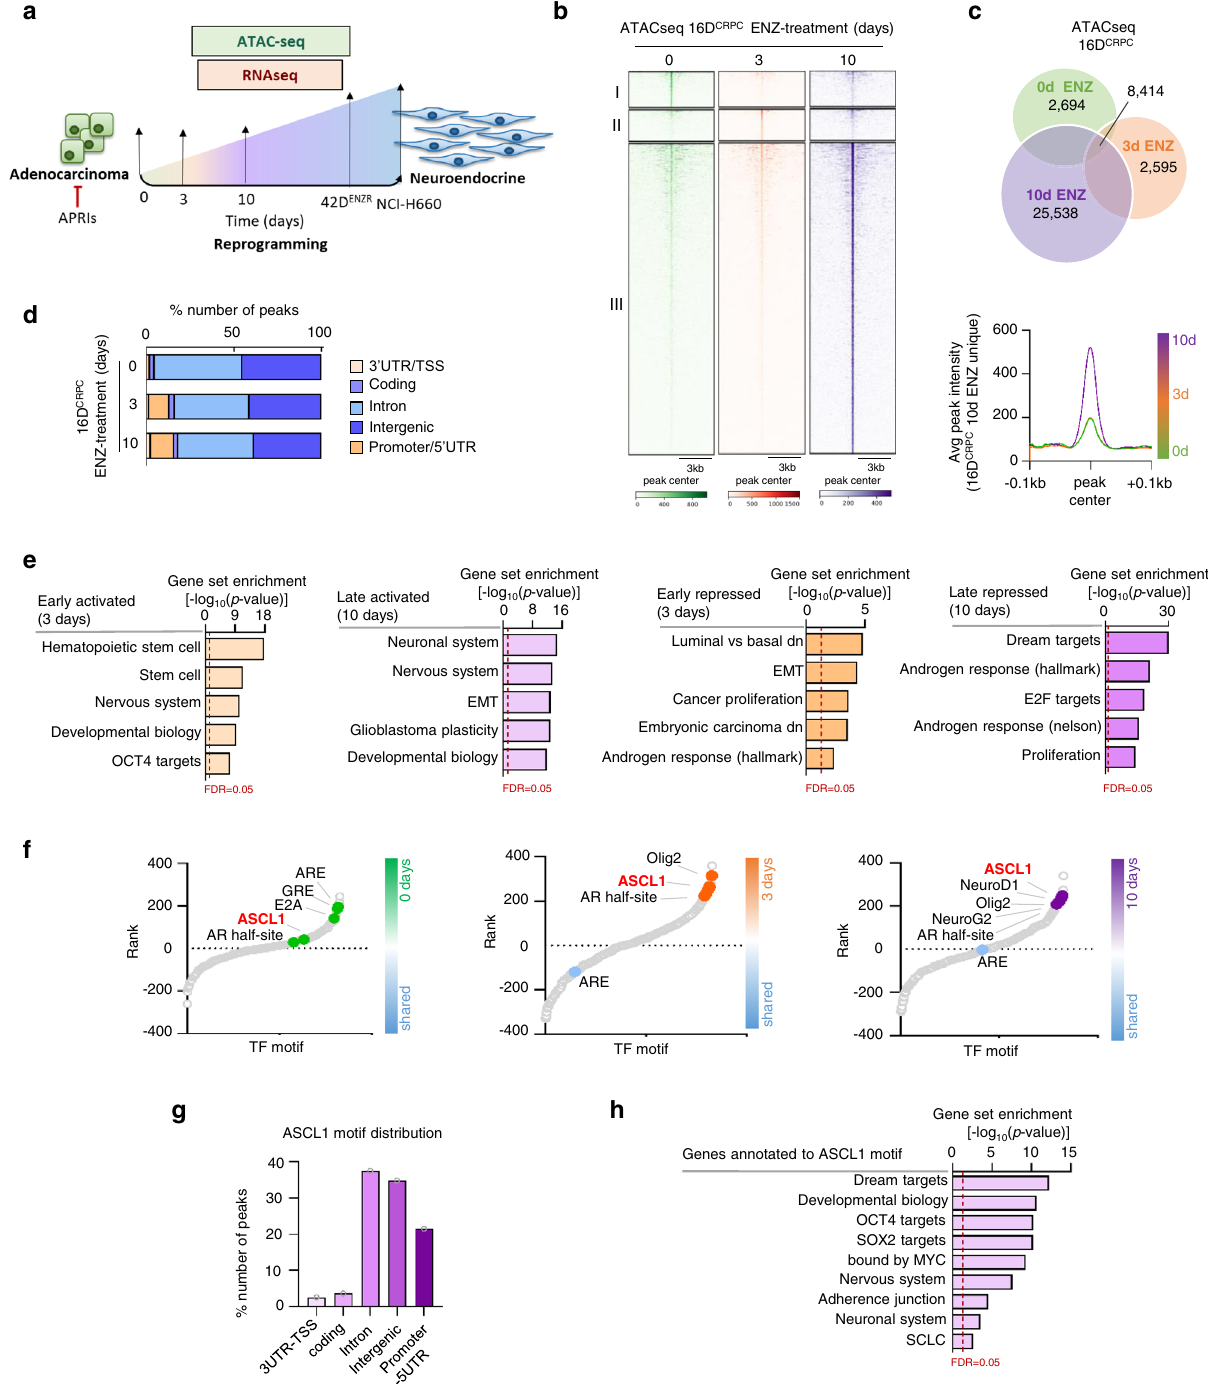
Fig. 1 Hormone therapy triggers epigenetic plasticity. a Schematic representation of the study outline. b Heatmap indicating accessibility in 16D CRPC with enzalutamide (ENZ) treatment for 0, 3, or 10 days ( n = 3 biologically independent samples). c Number of ATACseq peak (top) average signal pro fi le from unique 16D CRPC 10 day ENZ-treated regions (bottom). d Genomic annotation of all accessible peaks presented as percentage of all peaks. e Gene set enrichment analysis (GSEA) shows transcriptional response to ENZ treatment associated with gain/loss accessibility in 16D CRPC cells represented as: early repressed; late repressed; early activated; late activated. Dotted line represent false discovery rate (FDR) of 0.05, p < 0.05, statistical analysis was performed using a hypergeometric test. See also Supplementary Fig. 1. f Transcription factor (TF) binding motifs surrounding accessible chromatin in unique vs. shared regions, ranked based on differential p -value. Each dot represents a motif. Statistical analysis was performed using a cumulative hypergeometric test. g Genomic annotation for genes mapped to ASCL1 motif in 16D CRPC 10 days ENZ-treated, presented as percentage of all peaks. See also Supplementary Fig. 1. h Pathways associated to genes mapped to ASCL1 motif in 16D CRPC 10 days ENZ-treated. Dotted line represents FDR = 0.05, p < 0.05, statistical analysis was performed using a hypergeometric test. See also Supplementary Fig. 1. Source data are provided as a Source Data fi